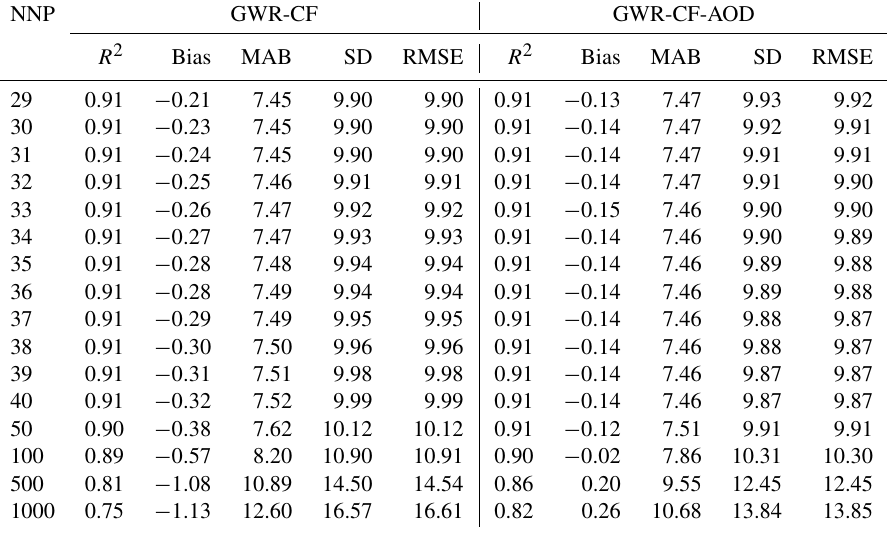
Table 3. Statistical summary of GWR parameter optimization. NNP is the number of nearest-neighbour points. GWR-CF presents the GWR- based fused method using only cloud fraction (CF) input, and GWR-CF-AOD presents that using both CF and aerosol optical depth (AOD) as input. MAB is the mean absolute bias. SD is the standard deviation. RMSE is the root-mean-square error.